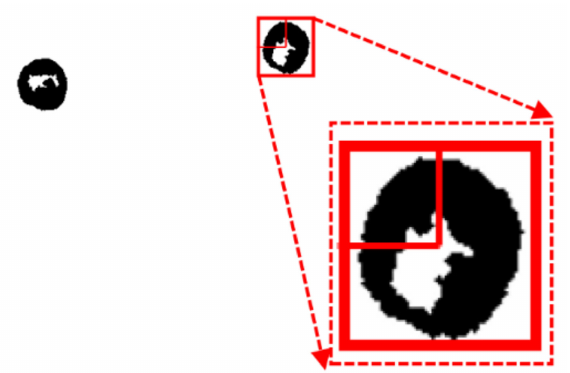
Figure 13. A method for calculating the cell area when the plane is rotated.